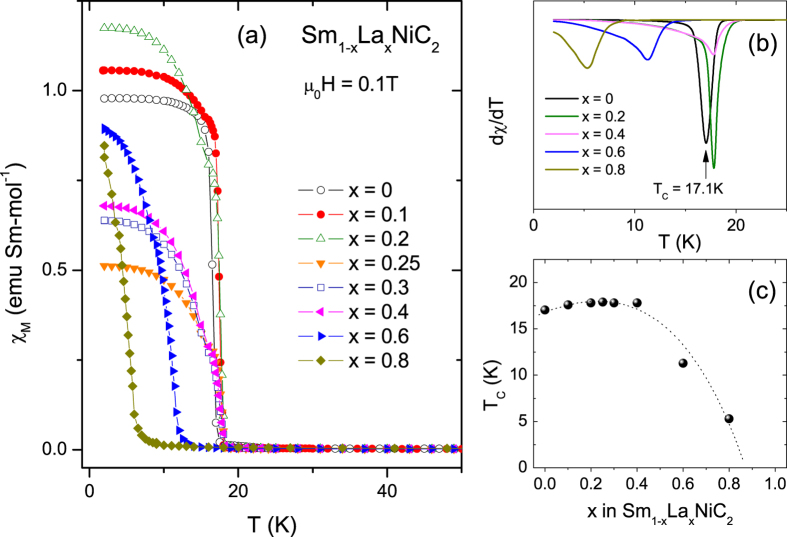
Magnetization for La-doped SmNiC2.(a) Molar magnetic susceptibility χM plotted against temperature for Sm1−xLaxNiC2, 0 ≤ x ≤ 0.80. (b) First temperature derivative of the susceptibility is representatively shown to determine the FM transition temperature TC for x = 0, 0.2, 0.4, 0.6, 0.8. Arrow marks the TC for x = 0, where dχM/dT is a minimum. (c) Evolution of TC as a function of La concentration x.